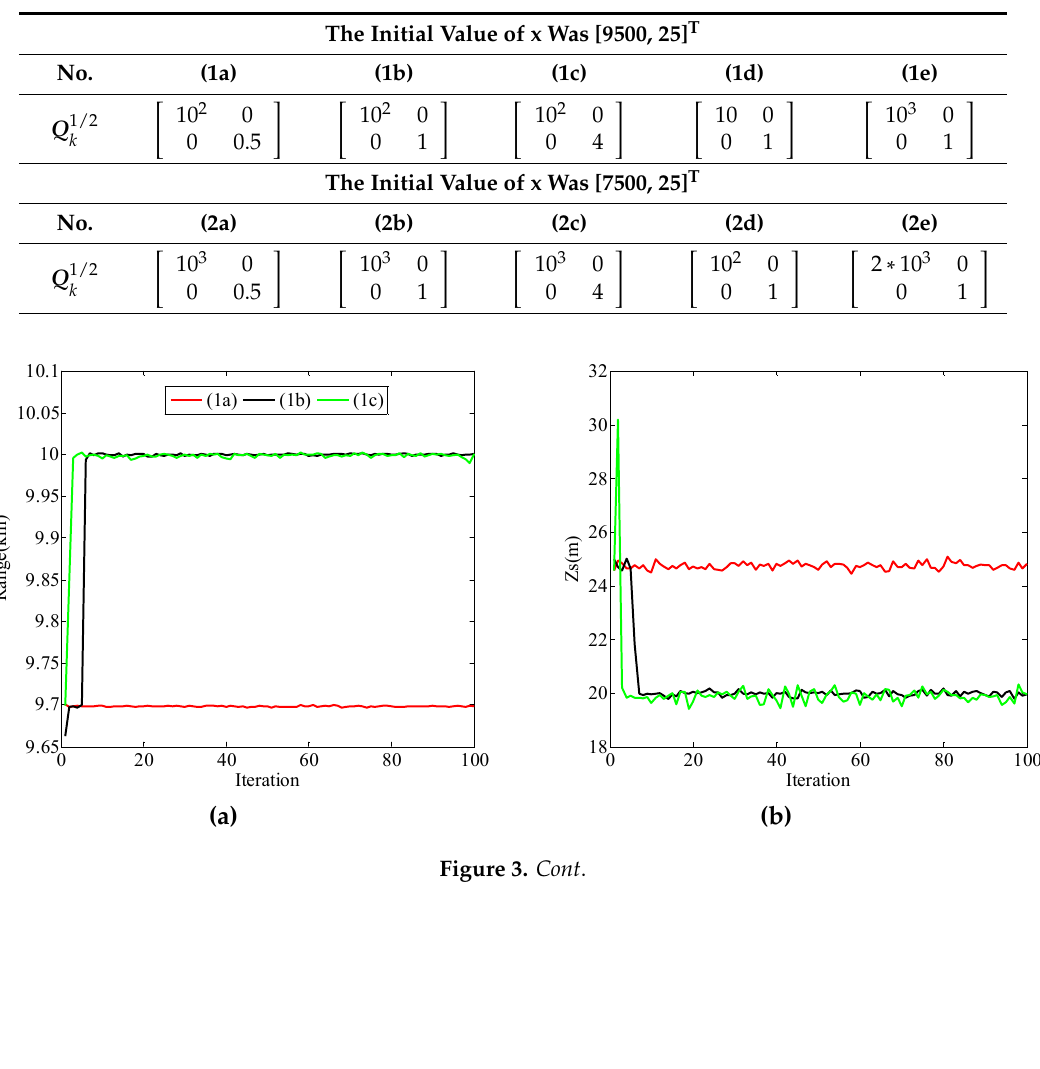
Q in different initial values of x . k in di ff erent initial values of x . k